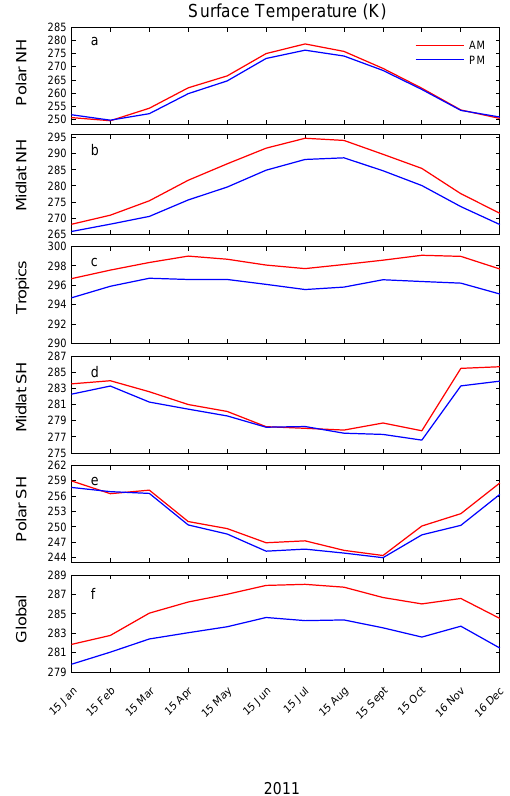
Figure 7. Same as Fig. 6 but for surface temperature in